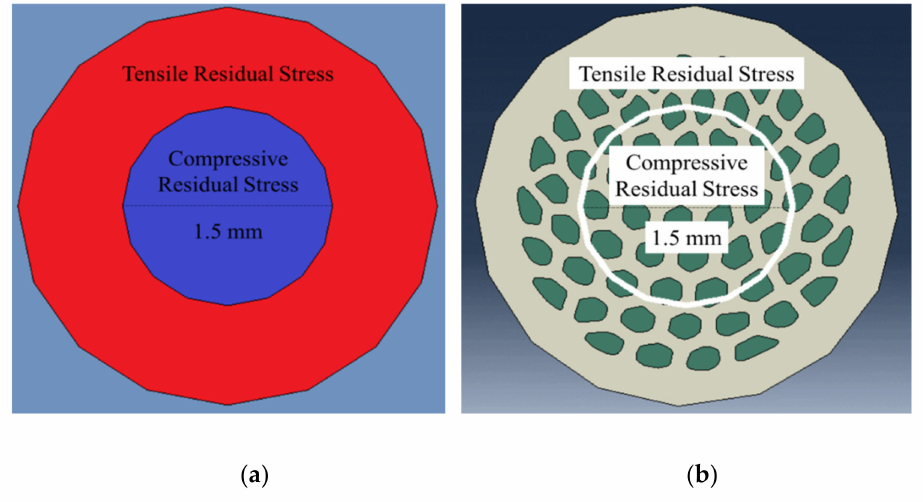
Figure 4. Predefined fields of residual stresses in ( a ) CCA and ( b ) ACCA wires (transversal